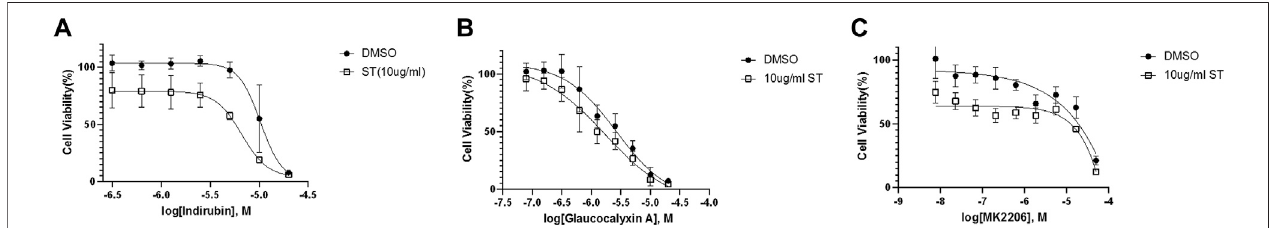
FIGURE 5 | Selected inhibitors that show synergistic effects with ST-539 (A) . The dose-response curve of 5-lodo-indirubin-3-monoxime on Jurkat T cells w/o ST- 539. Jurkat T cells were treated with 5-lodo-indirubin-3-monoxime in a concentration gradient manner with DMSO or 10 ug/ml ST-539 for 48 h. The cell growth was analyzed using a resazurin assay (B) . The dose-response of Glaucocalyxin A on Jurkat T cells w/o ST-539. Jurkat T cells were treated with Glaucocalyxin A in a concentrationgradientmannerwithDMSOor10 ug/mlST-539for48 h.Thecellgrowthwasanalyzedusingaresazurinassay (C) .Thedose-responseofMK2206 onJurkat Tcellsw/oST-539. JurkatTcellsweretreatedwithMK2206 inaconcentration gradientmannerwithDMSOor10 ug/mlST-539for48 h.Thecellgrowthwas analyzed using a resazurin